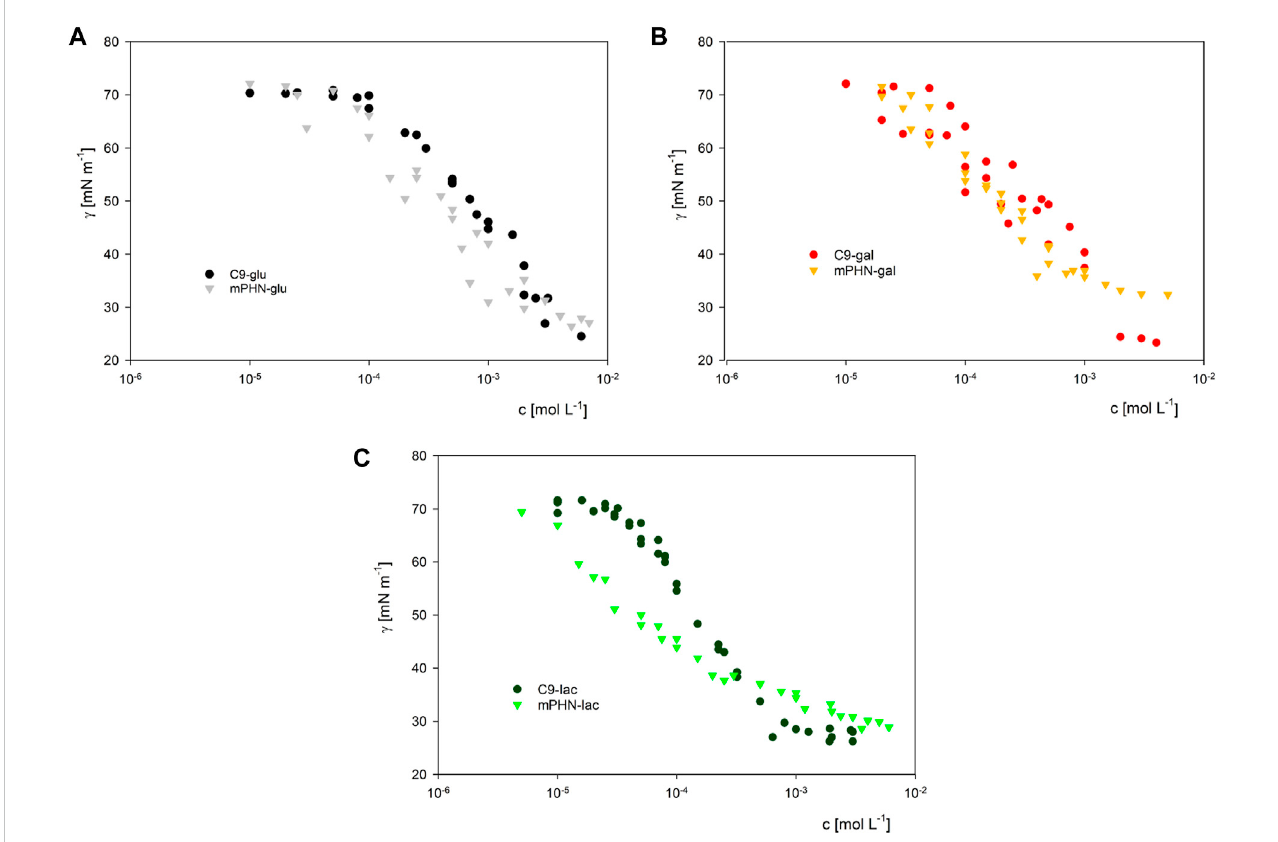
FIGURE 3 ThecomparisonofsurfaceactivityofbiocatalyticallysynthesizedmPHNsugaresterswiththeiraliphaticcounterparts.Respectivelyforglucose(PanelA), galactose (Panel B) and lactose (Panel C)